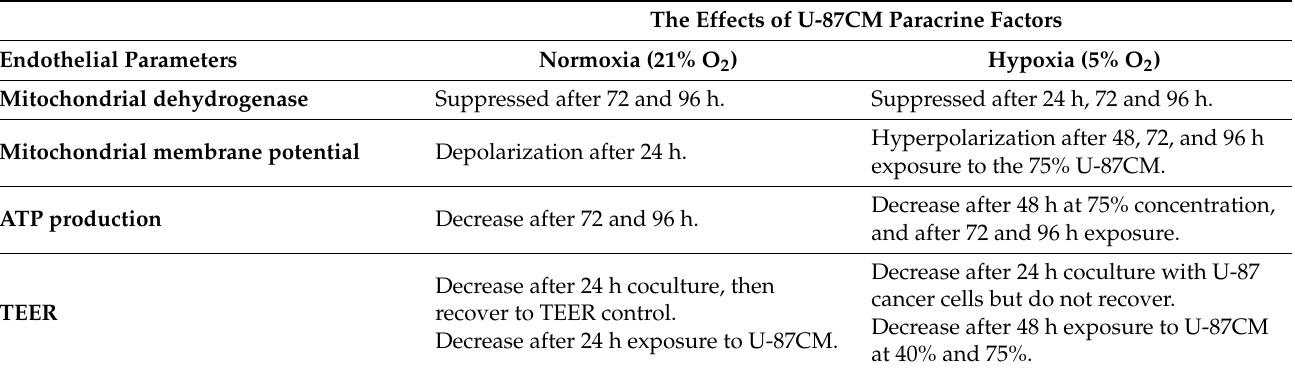
Table 2. A summary of U-87CM effects on brain endothelial cells (bEnd.3 cells). CM: conditional media. The Effects of U-87CM Paracrine